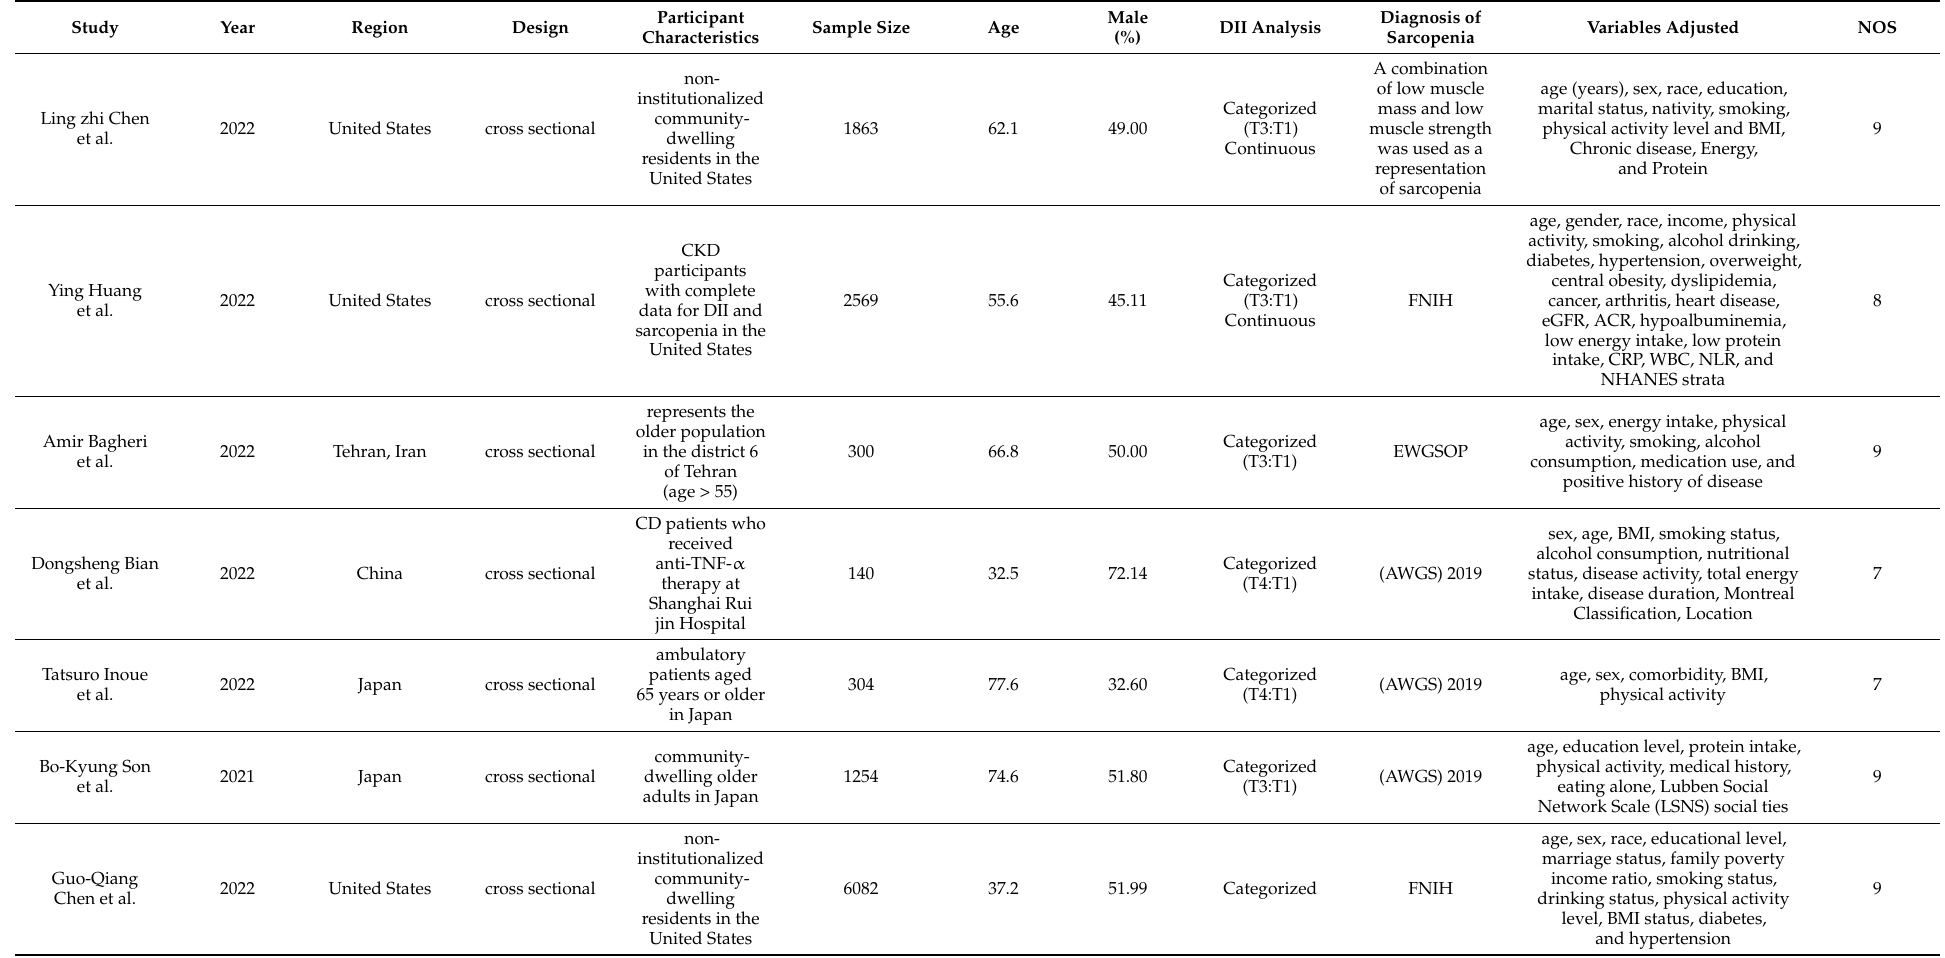
Table 1. Characteristics of the included observational